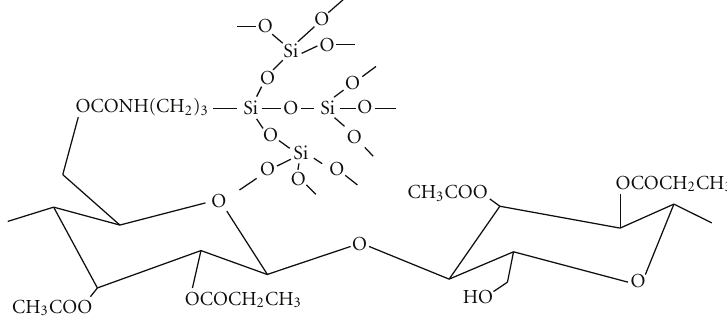
S 2: Chemical structure of